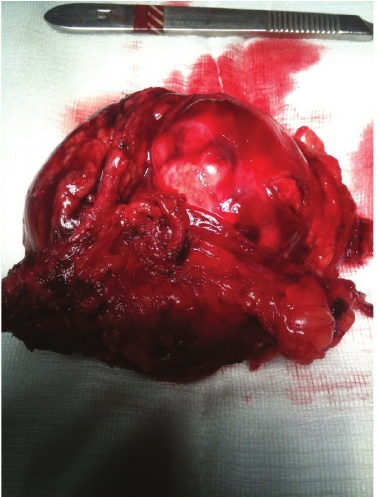
Figure 3: The surgical